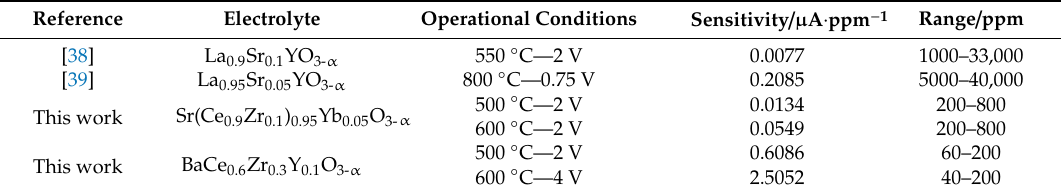
Table 3. Analytical parameters of the hydrogen sensors developed in this work and those found in the